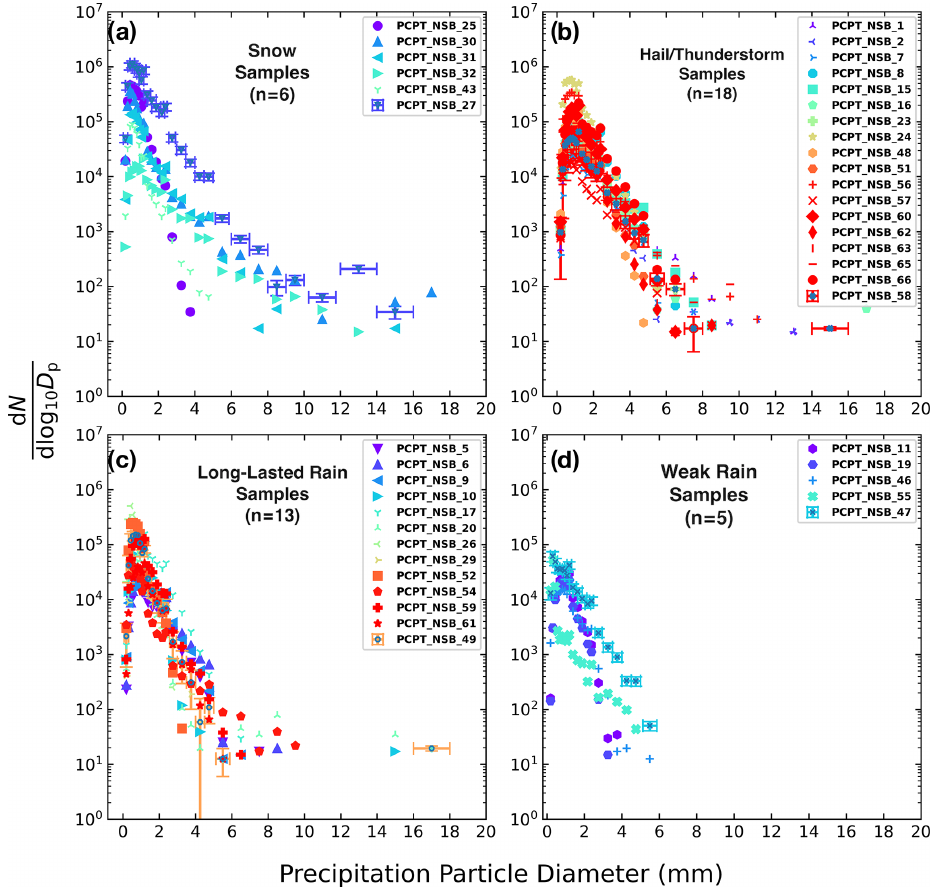
Figure 2. Size distribution of precipitation particles detected in (a) snow, (b) hail/thunderstorm, (c) long-lasted rain, and (d) weak rain samples. A subset of distributions shows varying uncertainty in diameter (mm). The x -axis error bars are ± 1.0mm of size class for diame- ter < 2mm and ± 0.5mm of size class for diameter > 2mm. The y -axis error bars represent standard errors at each diameter. The subtotal number of precipitation samples in each category is shown by the value of “ n